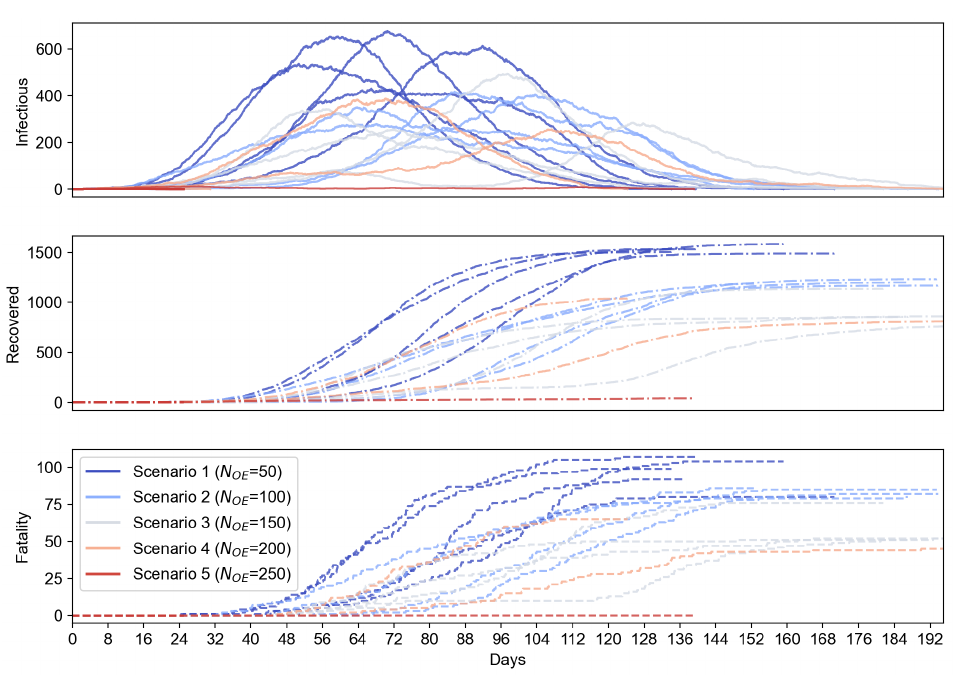
Figure 6. Infectious population vs. N OE ( s = 2.35 m/s, N OE = 200).